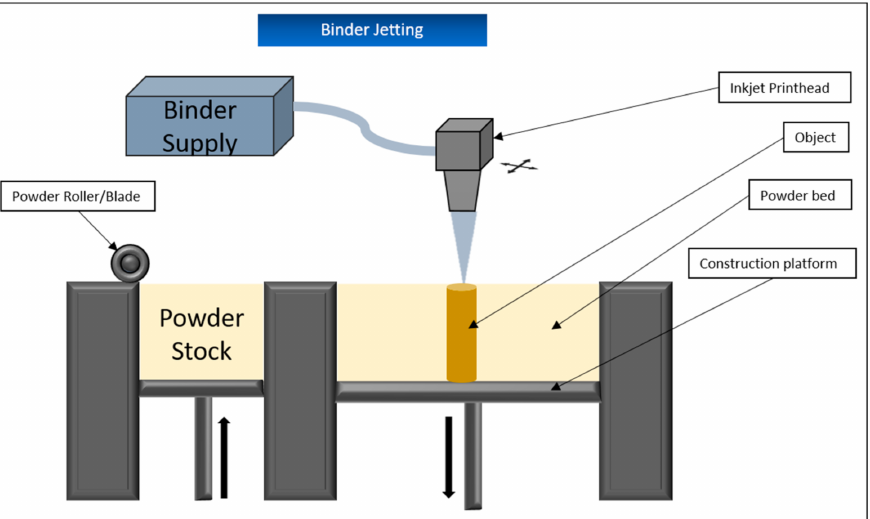
Figure 5. Schematic representation of the binder jetting printing technology. Powder layers that are added continuously are hardened at the required points using a liquid binding